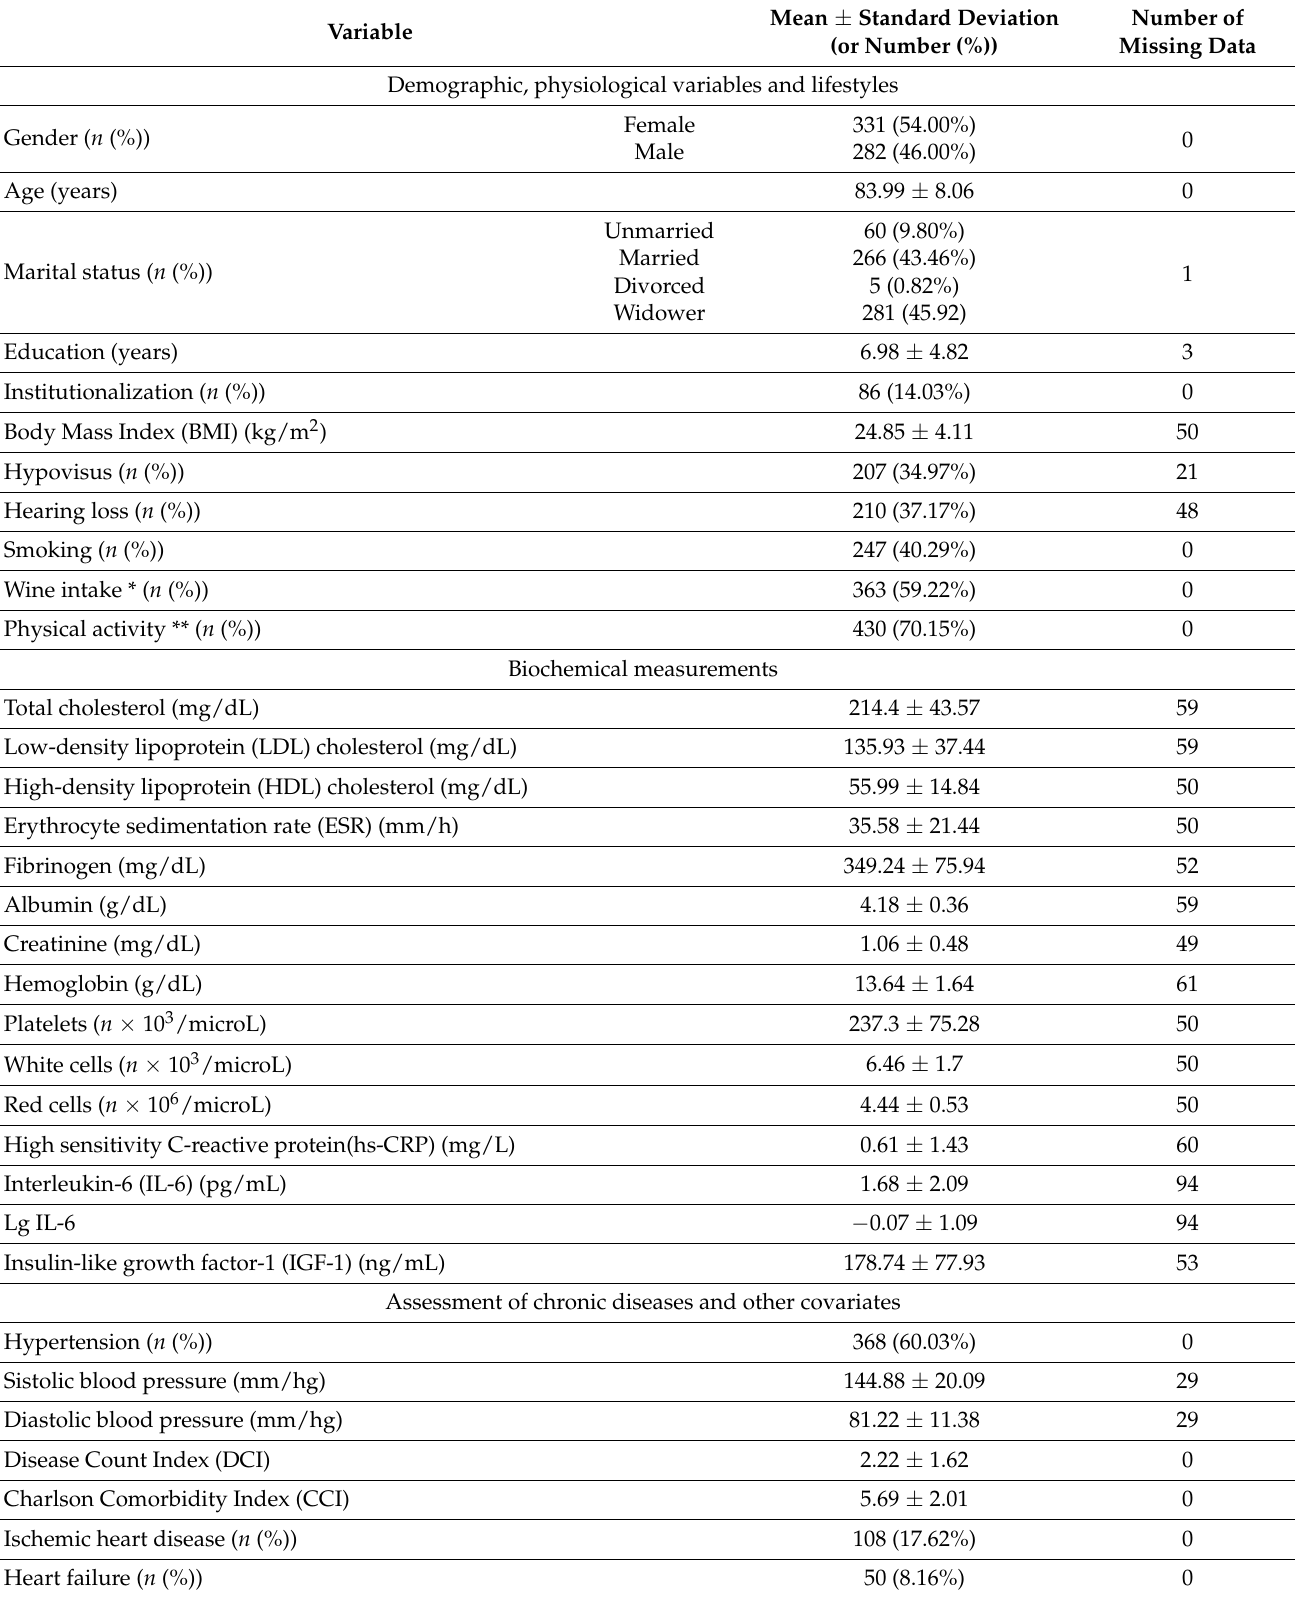
Mean ± Standard Deviation Number of (or Number (%)) Missing Data